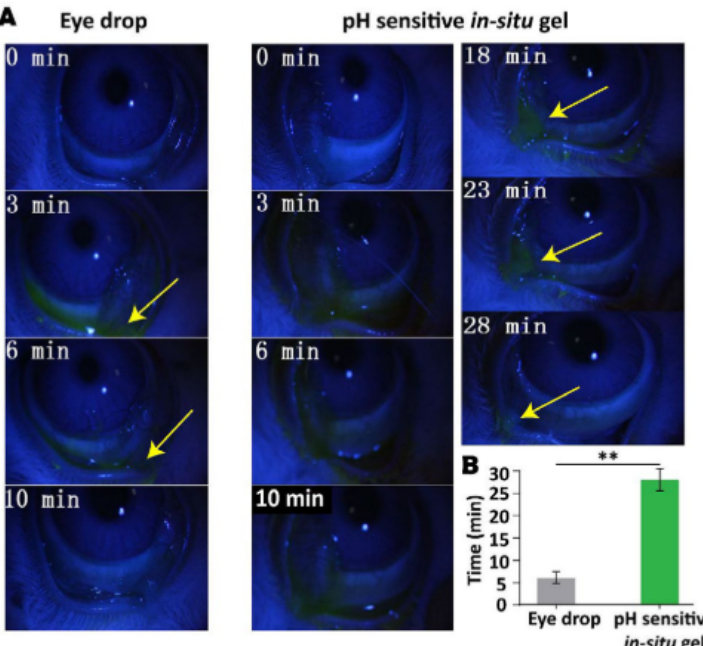
Figure 6. Ni et al. revealed ( A ) in vivo dwelling time of marketed bear bile eye drops and advanced formulation displayed by fluorescence-gel formulation, the residence time was remarkably longer in advanced formulation compared to marketed drops; ( B ) the retention time of marketed bear bile and advanced formulation, where ** p < 0.01 [75].